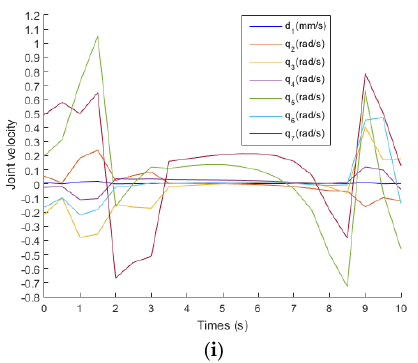
Figure 6. Simulations results of the proposed IWGPM. ( a ) the change curve of joint position; ( b ) the change curve of position deviation; ( c ) the change curve of orientation deviation; ( d ) the change curve of w c ( q i ) ; ( e ) the change curve of r i ; ( f ) the change curve of σ min ; ( g ) the change curve of λ 2 ; ( h ) the change curve of F i ; ( i ) the change curve of joint